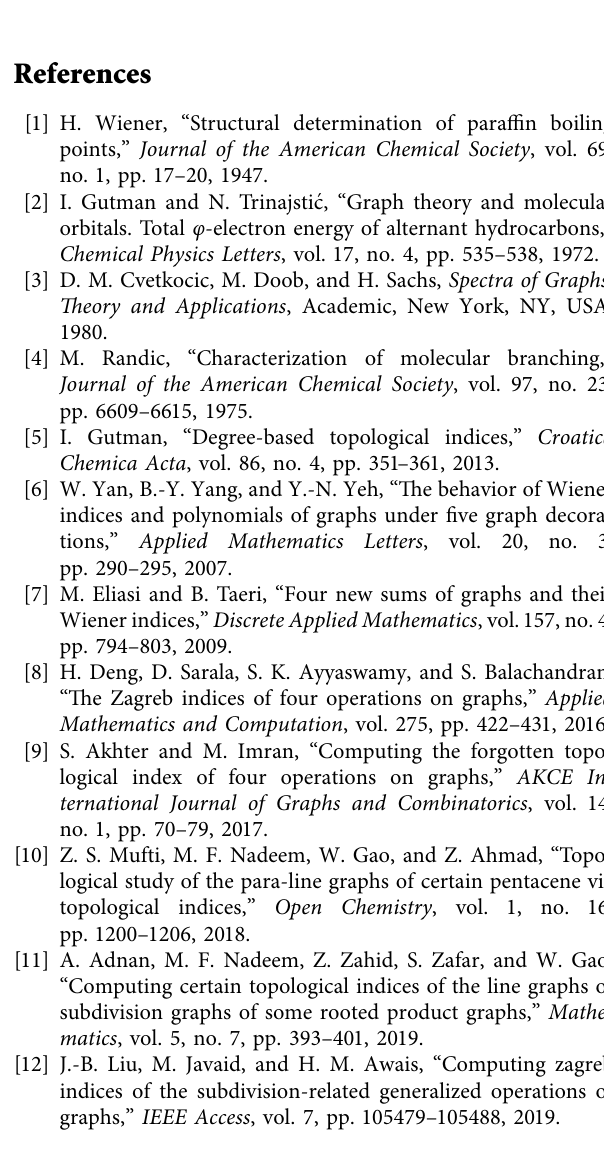
Figure 9: Numerical comparison of Zagreb indices of generalized subdivision and semitotal point operations with lexicographic product of the networks for M